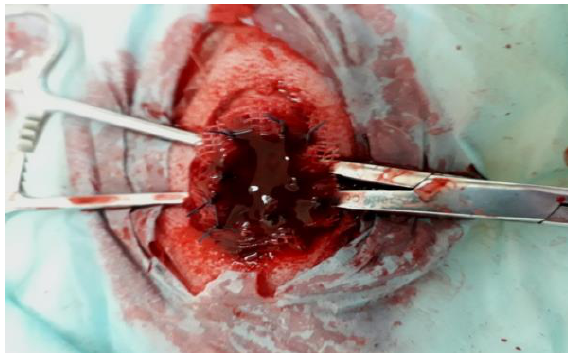
Figure, 4: Shows tracheal defect of dog in G2 were covered by polypropylene mesh and bone